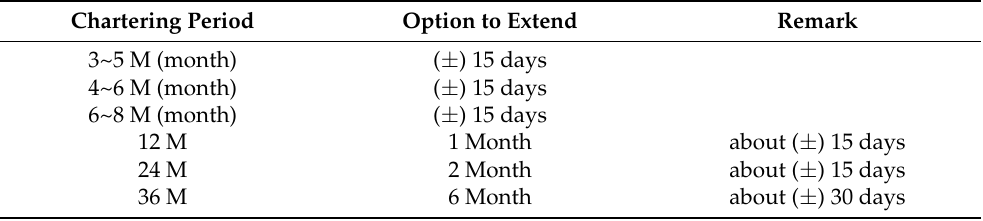
Table 1. Chartering period and option to extend for LNG